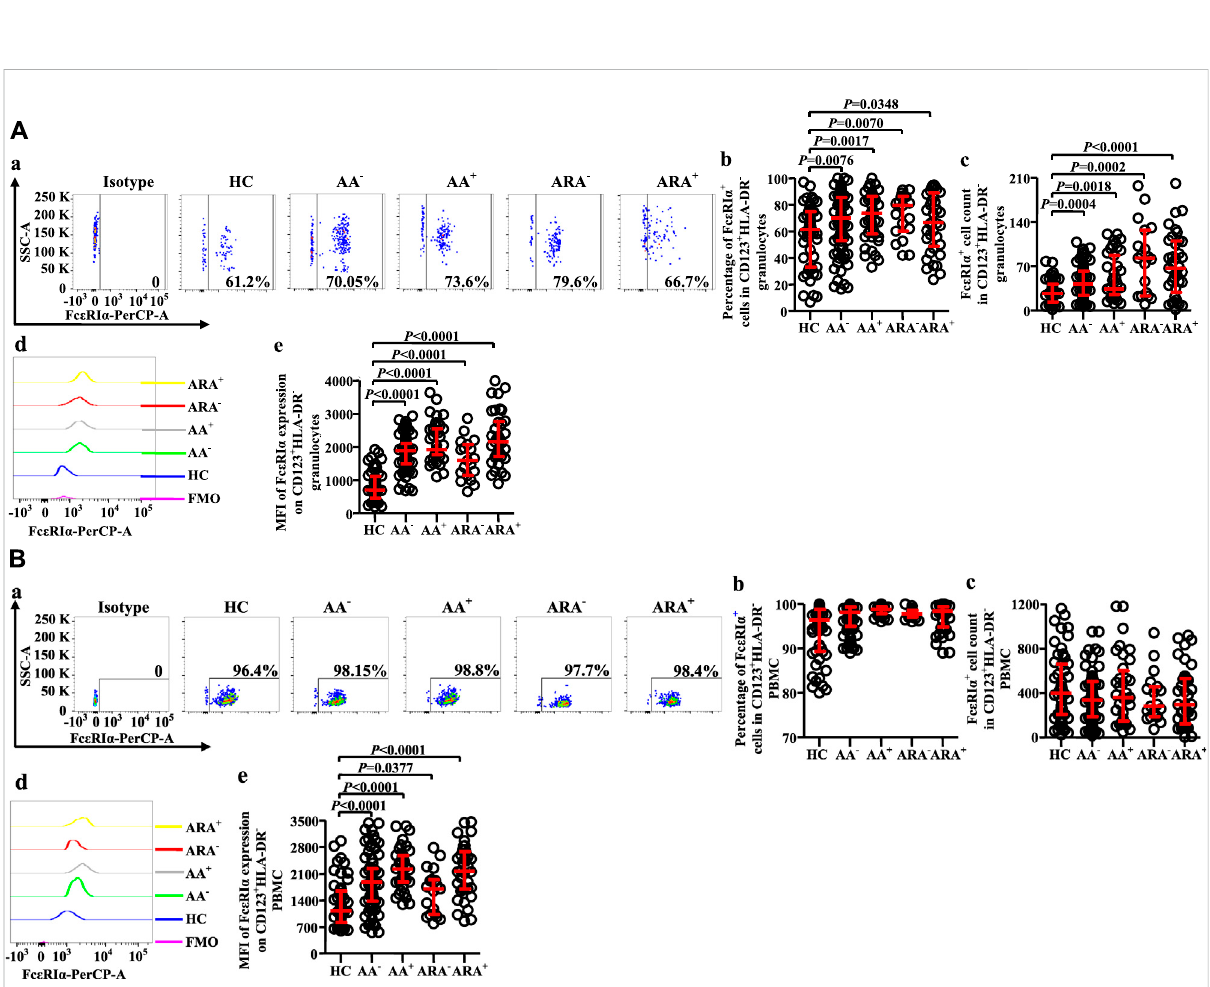
FIGURE 5 Flow cytometry analysis of Fc ε RI α expression in CD123+HLA-DR − granulocytes and PBMC of AA and HC subjects. (A) and (B) proportions and numbers of Fc ε RI α + cells in CD123+HLA-DR − granulocytes and PBMC. (a) Representative graphs of the gating strategies. (b) percentages indicated cells of skin prick test (SPT)-negative AA (AA − ), SPT-positive AA (AA+), SPT-negative AA combined with allergic rhinitis (ARA − ), and SPT-positive AA combined with allergic rhinitis (ARA+) patients and HC subjects. (c) numbers of Fc ε RI α + cells in CD123+HLA-DR − cells indicated. (d) representative graphs and (e) MFI of Fc ε RI α expression on CD123+HLA-DR − cells indicated.